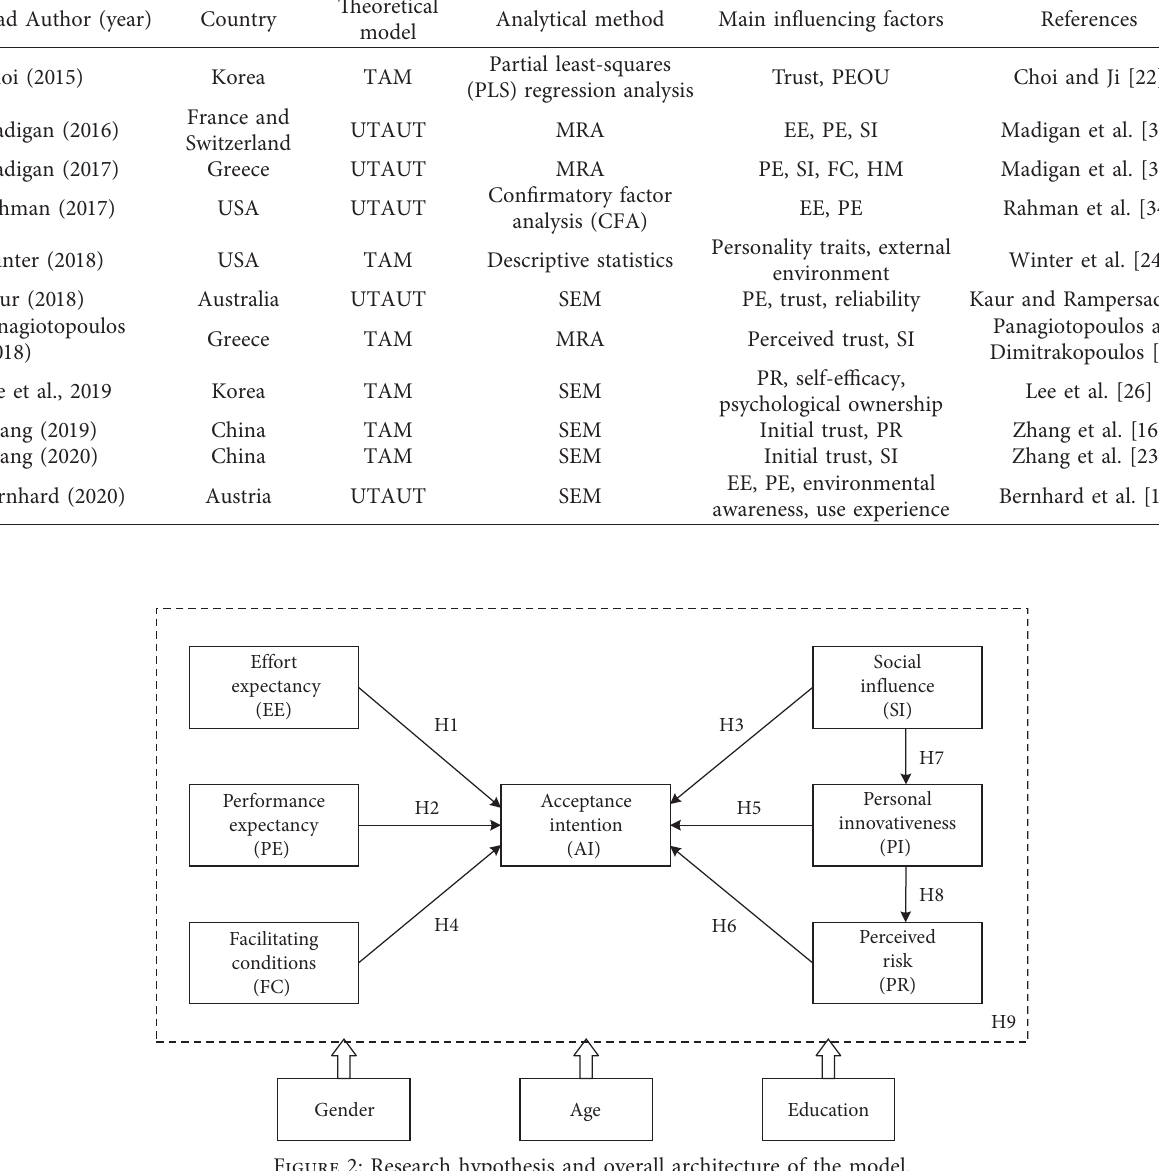
Figure 2: Research hypothesis and overall architecture of the